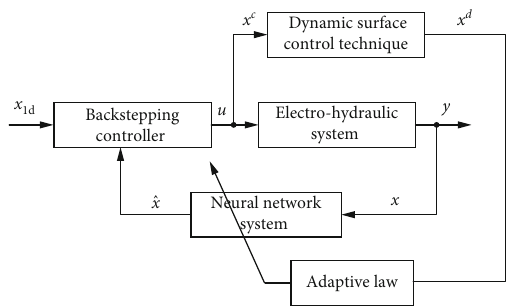
Figure 3: Block diagram of the control